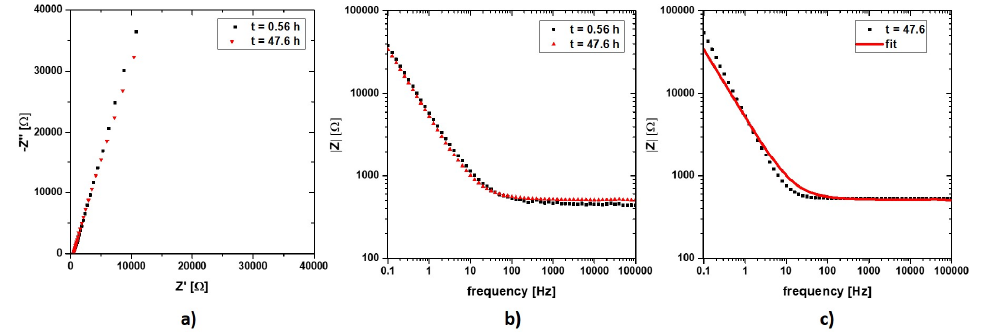
Figure 2. Exemplary raw data for two time points of the lab scale cultivation: ( a ) Nyquist plot; ( b ) Bode plot using absolute value of the impedance; ( c ) fit with ideal capacity model.